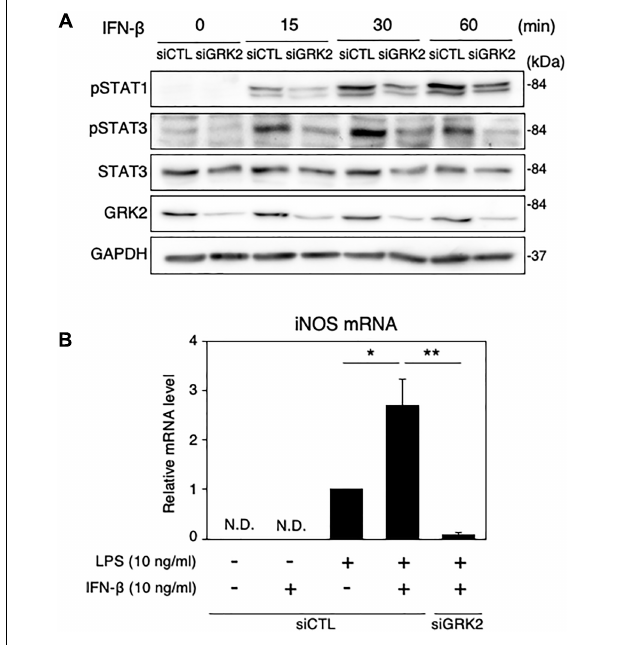
FIGURE 9 | Effect of GRK2 siRNA transfection on phosphorylation levels of STAT1 and STAT3 and mRNA levels of iNOS in MG6 cells supplemented with exogenous IFN- β . (A) Time course of changes in phospho-STAT1 at Tyr-701, phospho-STAT3 at Tyr-705, and total STAT3 after supplementation with 10 ng/ml IFN- β . Transfection of siGRK2, but not of siCTL, effectively decreased GRK2 protein expression, and GAPDH was used as loading control. Shown are representative Western blots from three independent experiments in which the same results were obtained. (B) Effect of siGRK2 transfection on expression of iNOS mRNA 12 h after 10 ng/ml IFN- β supplementation in the presence of 10 ng/ml LPS. The mRNA levels were expressed as a fold increase above control normalized GAPDH. The results represent the mean ± SEM for four independent experiments. N.D., not detected. ∗ P < 0.05, ∗∗ P < 0.01 by t-